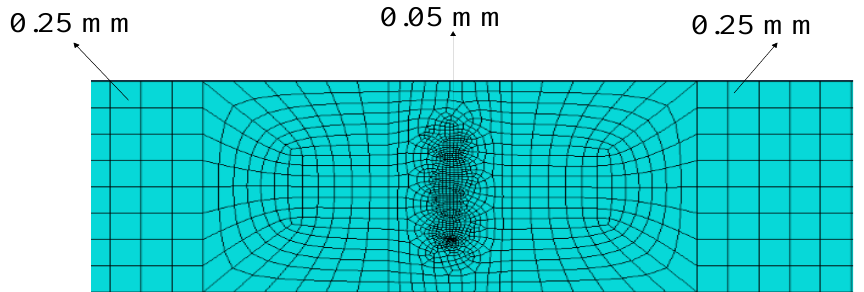
Figure 8. Mesh size in different regions: for the region between the actuator and the crack and, the zone between the crack and the receiver, the mesh size was 0.25 mm, for the cracked area the mesh size was very small equaling to 0.05